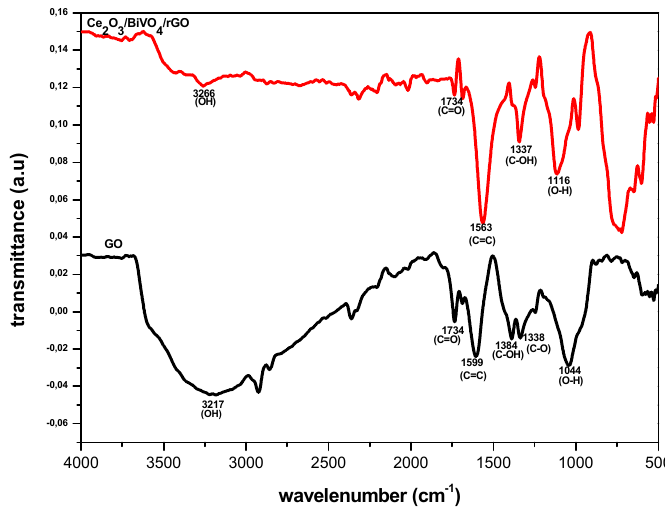
Figure 5. FTIR spectra of the synthesized GO and Ce 2 O 3 /BiVO 4 /rGO.